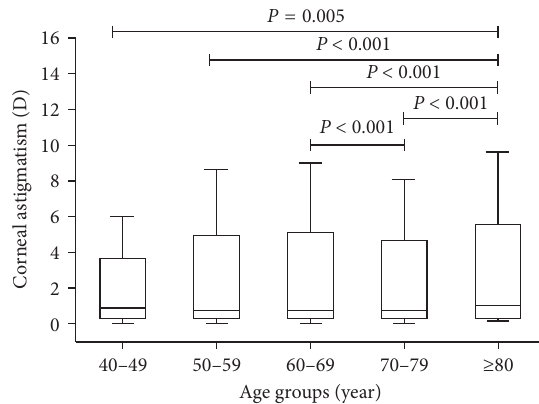
Figure 2: Corneal astigmatism in different age groups. Boxes show the interquartile range. Bold lines in boxes represent the median, and the whiskers represent extreme values.